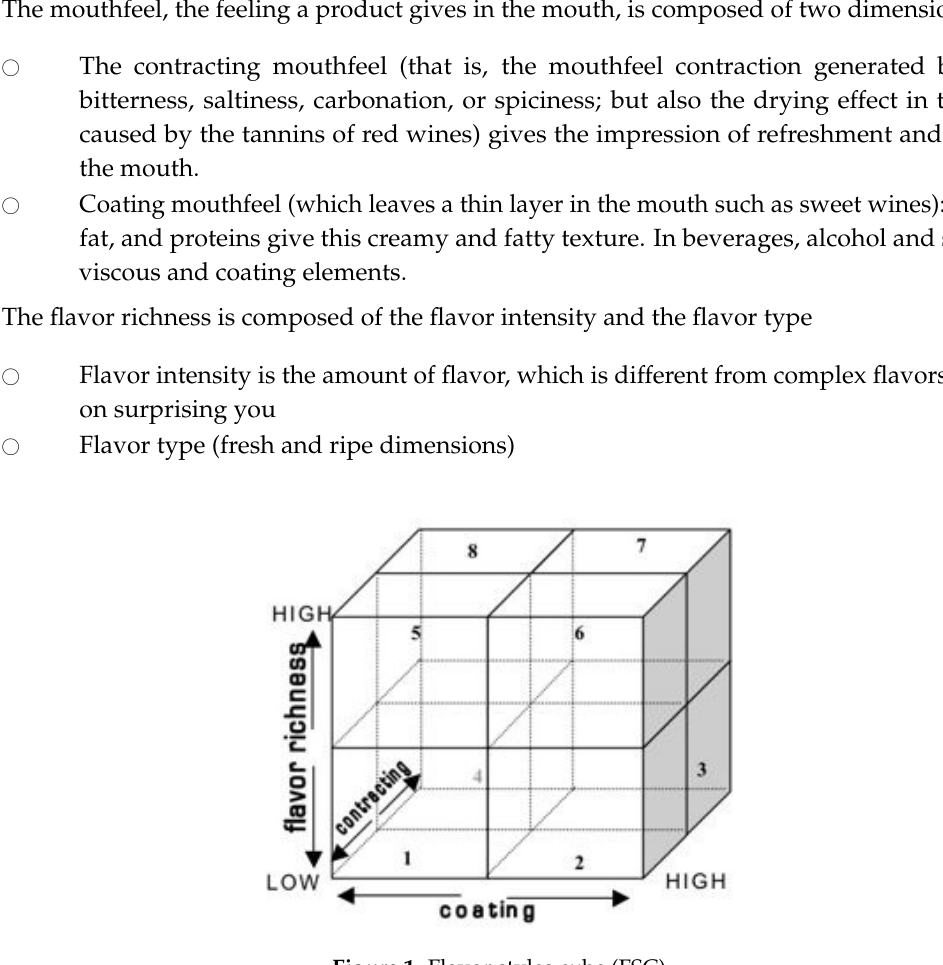
Figure 1. Flavor styles cube (FSC).